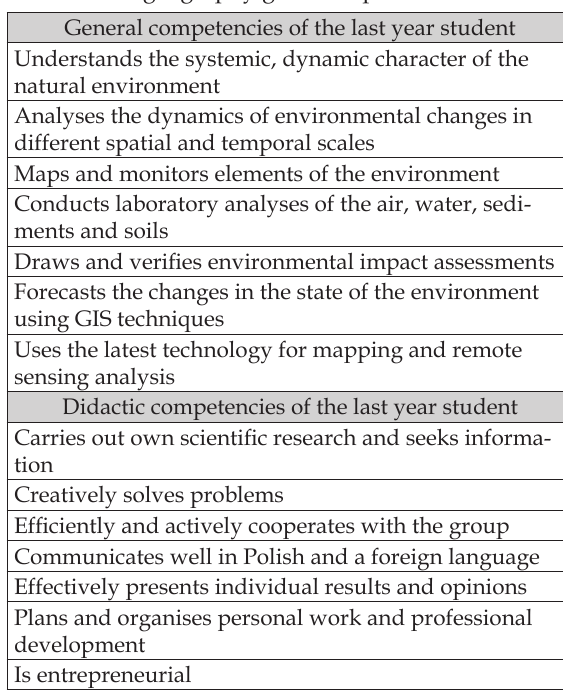
Table. 1. Competencies and qualifications listed in a geography graduate